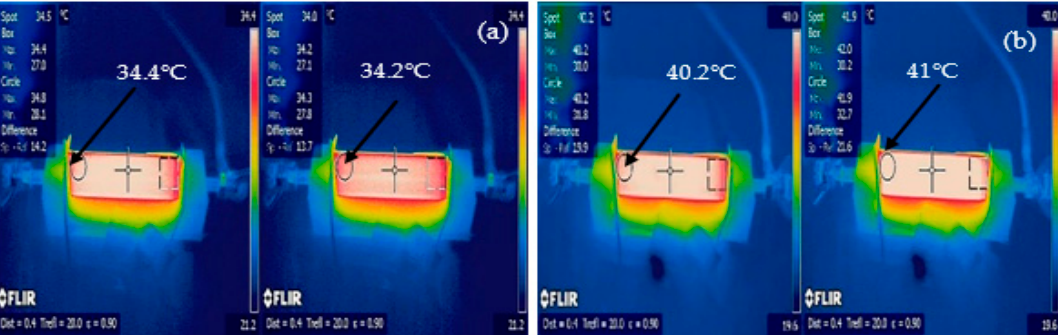
Figure 11. IR camera thermal images of sidewall surface and terminal temperatures of the battery when discharged to the 2.5 V cut-o ff voltage for ( a ) the 2C discharge rate and ( b ) the 3C discharge